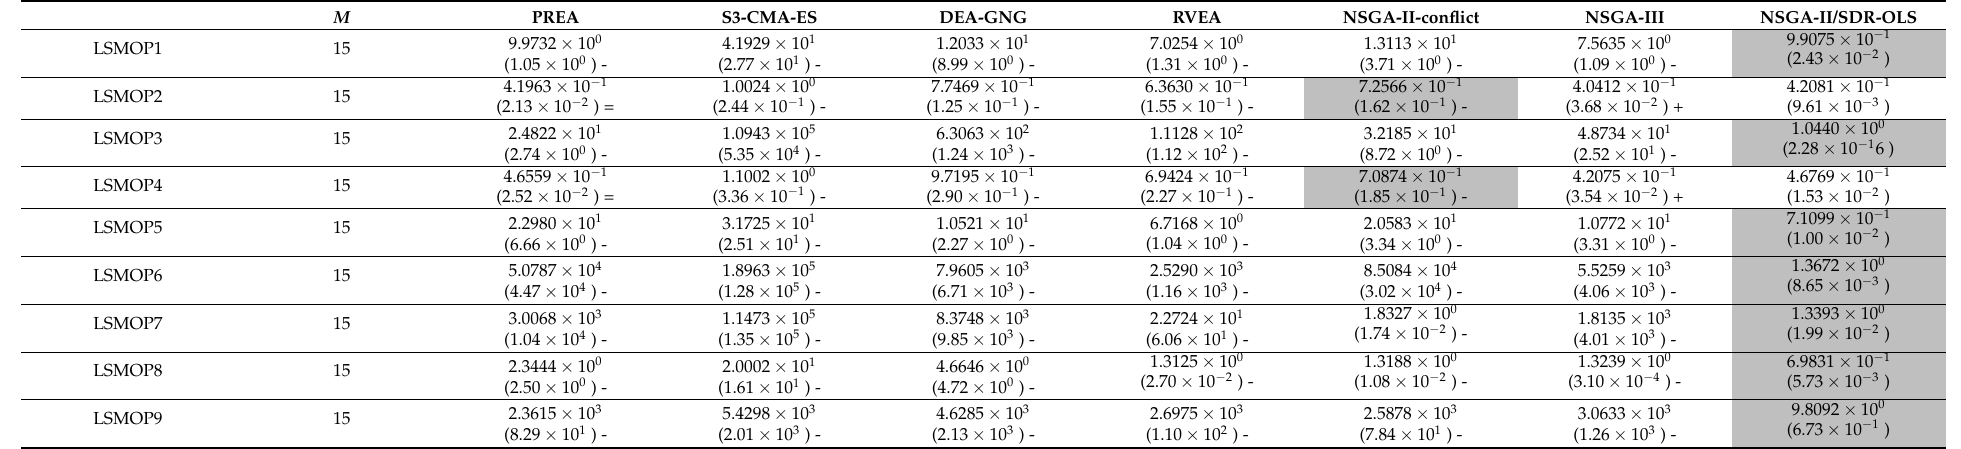
Table 16. IGD values for 9 fifteen-objective benchmark problems.